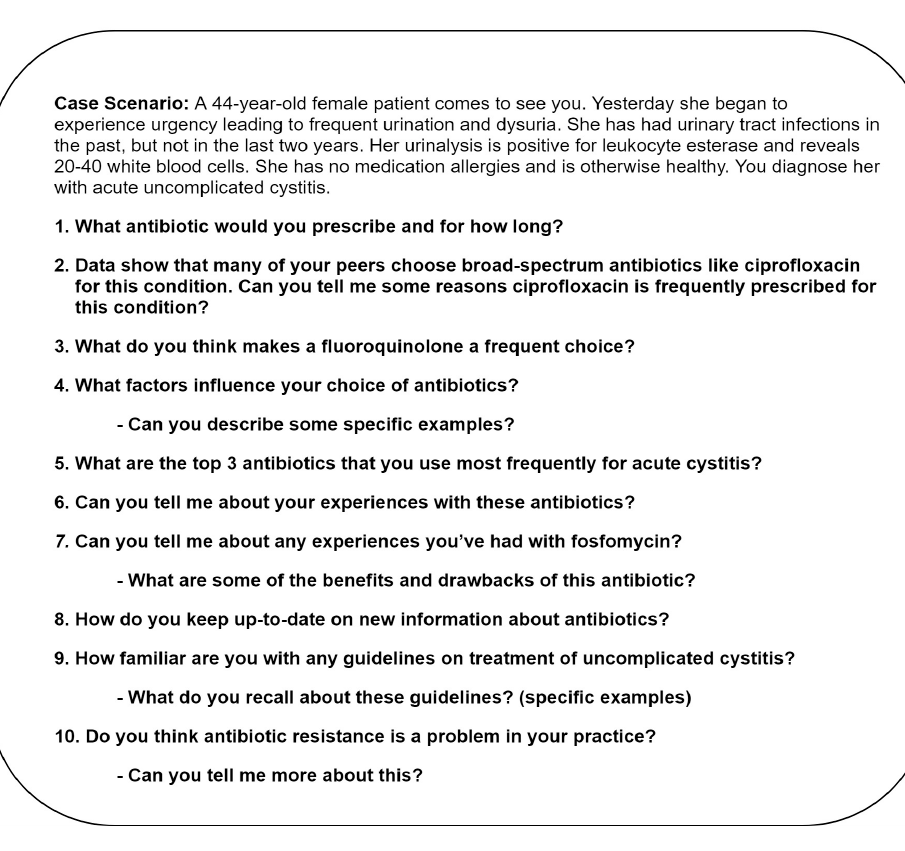
Figure 2. Sample interview questions.